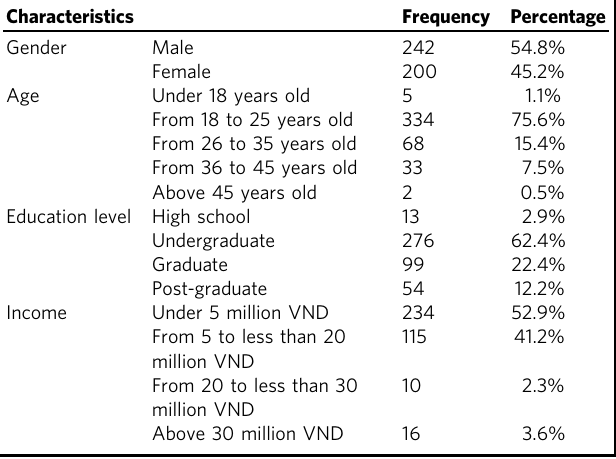
Table 4 Sample descriptive statistics. Characteristics